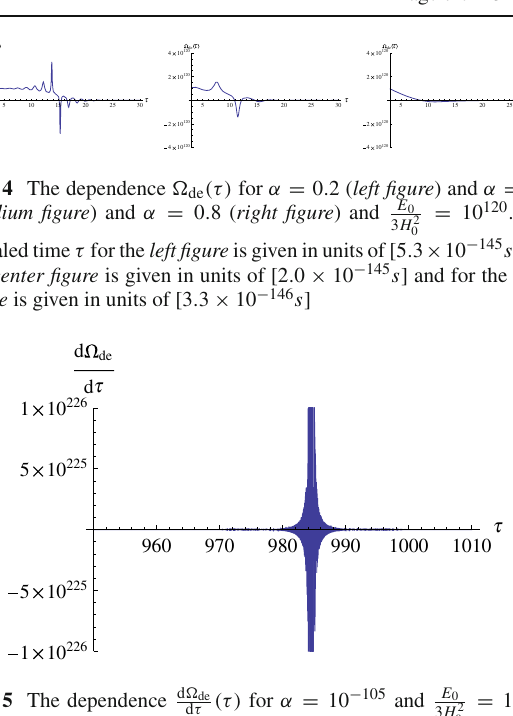
(τ) for α = 10 − 105 and E 0 = 10 120 . d τ 3 H 2 0 , the energy is transferred from d τ , d τ